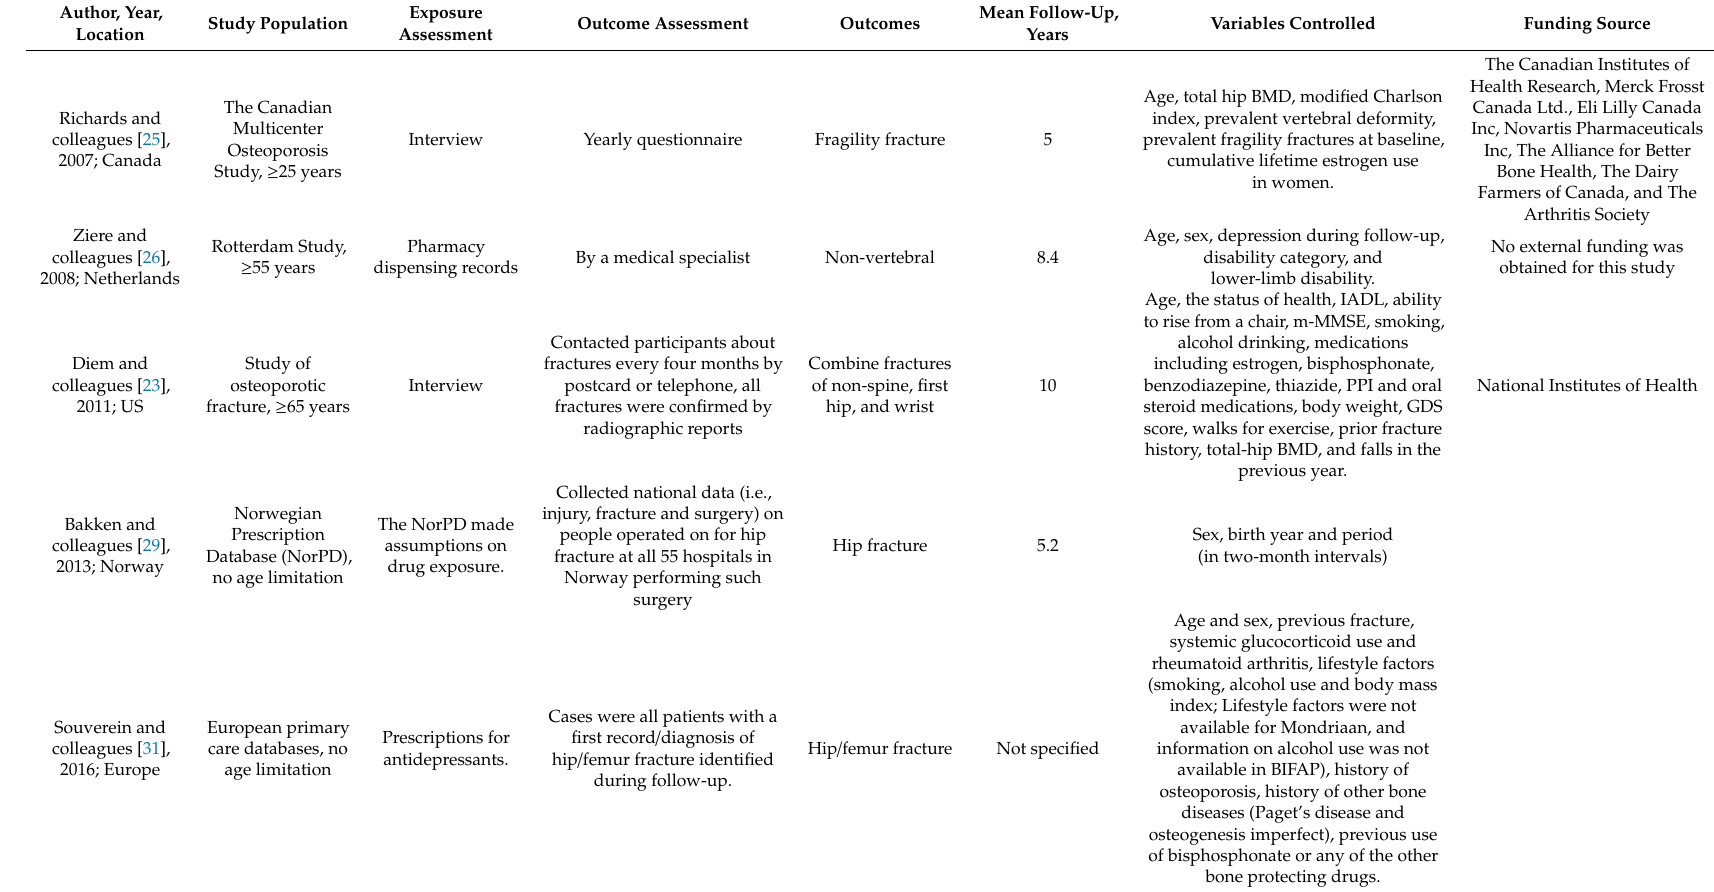
Table 1. Characteristics of eight cohort studies on the association of tricyclic antidepressants with fracture